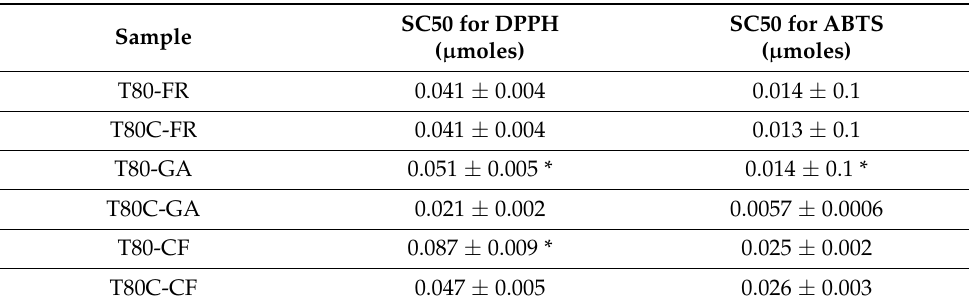
Table 3. SC50 values of antioxidant-functionalized niosomes in DPPH and ABTS scavenging assay. Results represent the mean ± S.D. of three independent experiments performed with triplicate measurements. * p < 0.05 phenolic acid-conjugated T80 niosomes vs. phenolic acid-conjugated T80C niosomes. SC50 for DPPH SC50 for Sample ( µ moles)